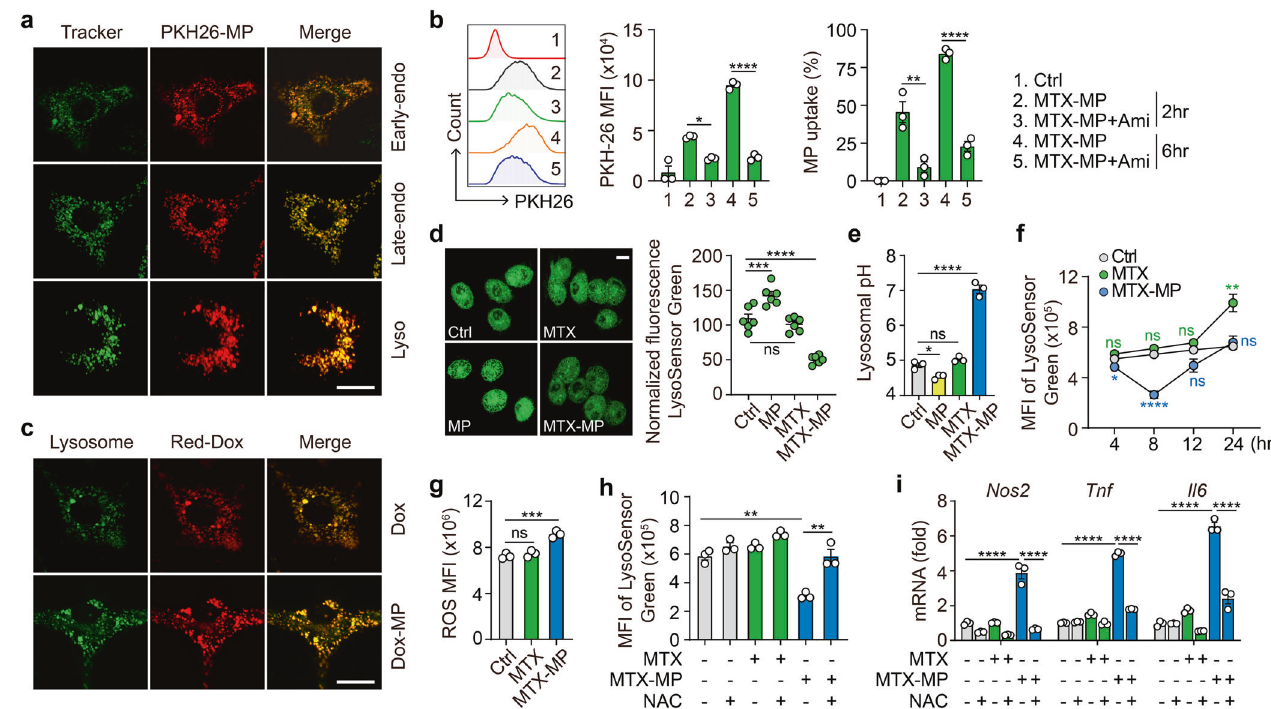
Fig. 2 Drug-MPs increase ROS-dependent lysosomal pH. a IL-4 conditioned BMDMs were incubated with PKH26-labeled MTX-MPs and analyzed with early-endosomes, late-endosomes or lysosomes under a two-photon confocal microscope. b IL-4 conditioned BMDMs were treated with PKH26-labeled MTX-MPs in the presence or absence of amiloride hydrochloride (Ami, 75 μ M) and the uptake of MTX-MPs was determined by fl ow cytometry. c IL-4 conditioned BMDMs were treated with Dox or Dox-MPs for 8 h and then the red- fl uorescent Dox and lysosomes (Green) were observed under a two-photon confocal microscope. d , e IL-4 conditioned BMDMs were treated with T-MPs, MTX or MTX-MPs for 8 h. LysoSensor Green labeled acidic lysosomes were observed under a fl uorescence microscope (d), pH value of lysosomes was detected by a microplate reader ( e ). f IL-4 conditioned BMDMs were treated with MTX or MTX-MPs and the MFI of LysoSensor Green was detected at different time points by fl ow cytometry. g IL-4 conditioned BMDMs were treated with MTX or MTX-MPs for 8 h and ROS level